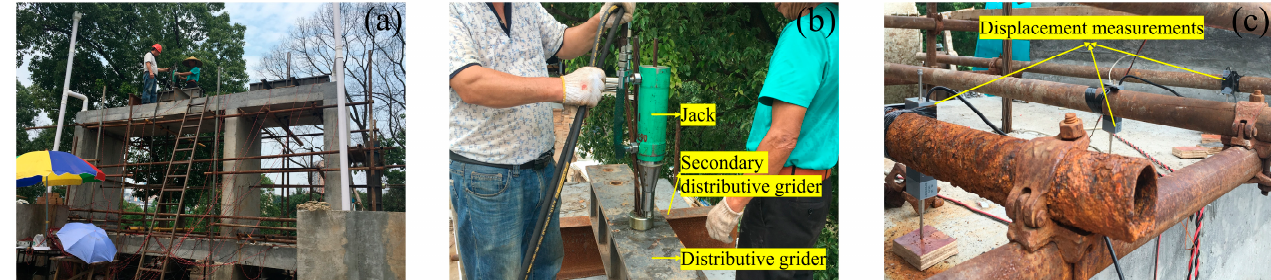
Figure 5. On-site loading of the prefabricated utility tunnel: ( a ) full-scale utility tunnel; ( b ) jack; and ( c ) displacement measurements.